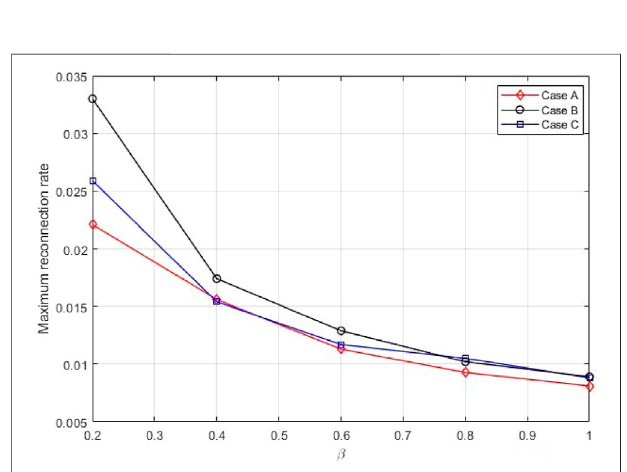
FIGURE11| Timevariationofmagneticreconnectionfordifferentvalues of β in presence of non-uniform guide fi eld.